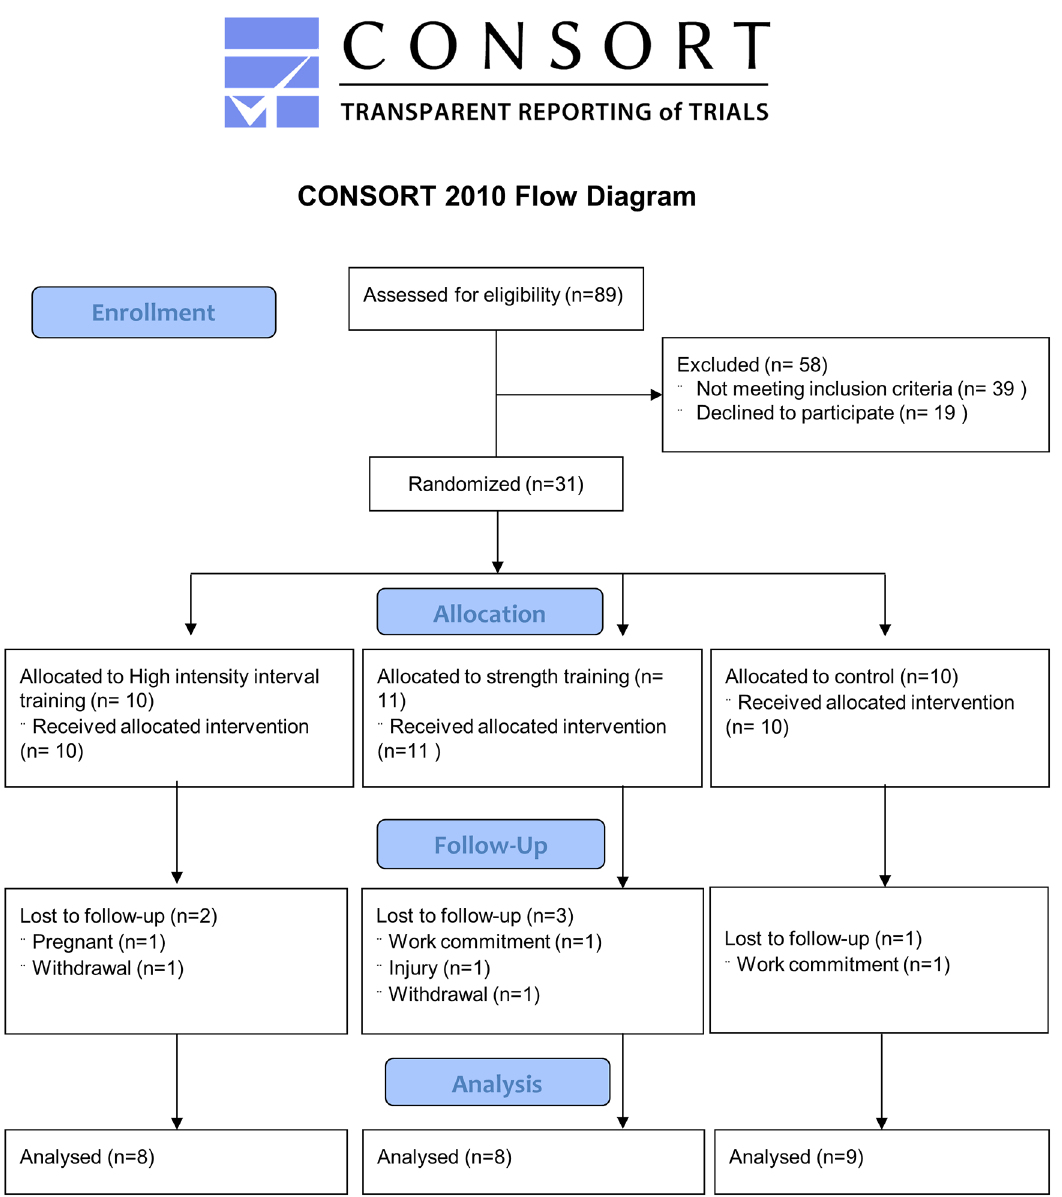
Fig 1. Flow-chart of the study